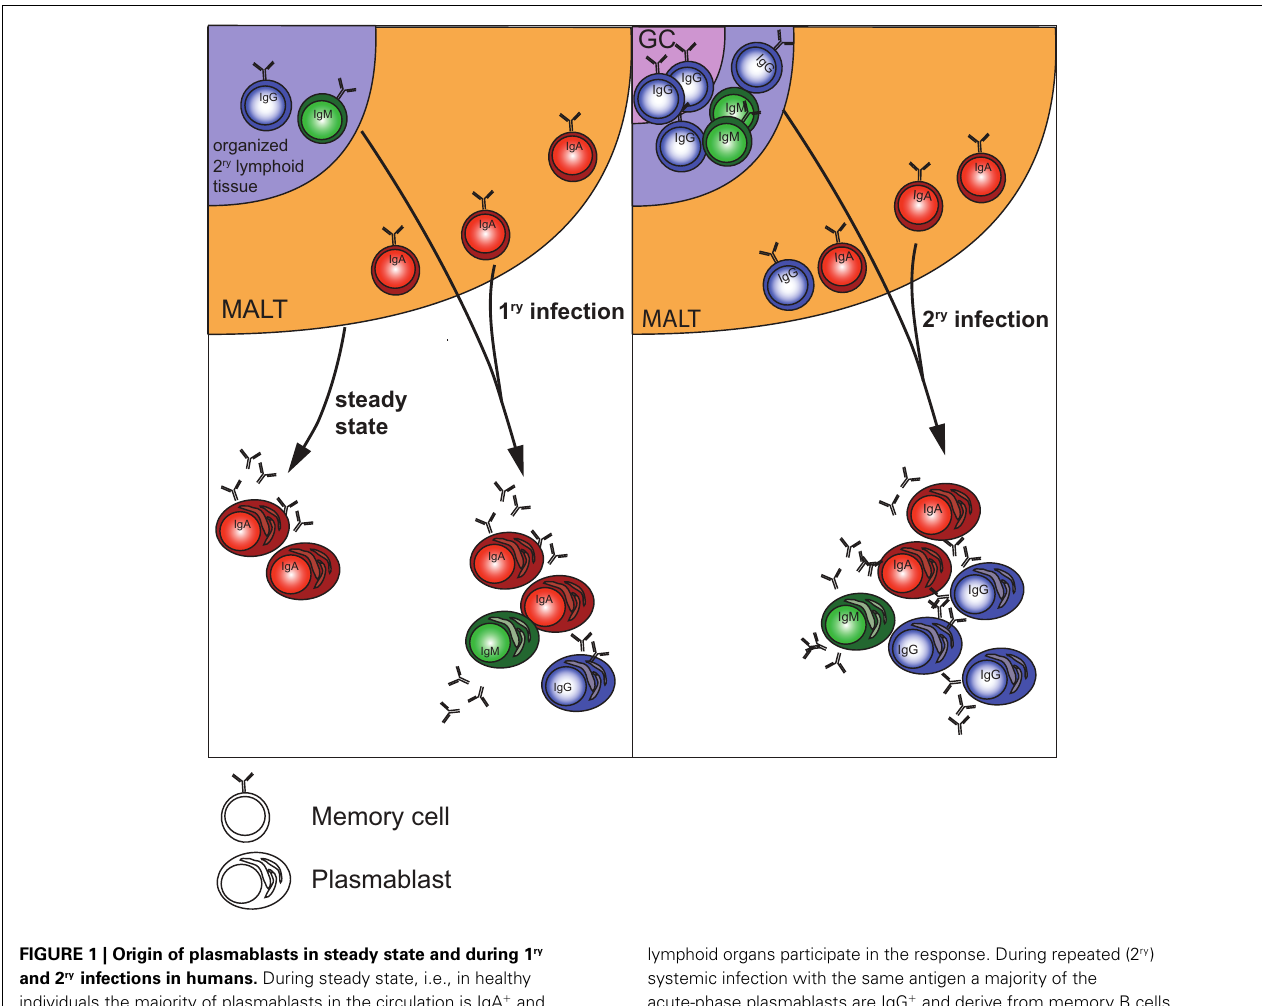
lymphoid organs participate in the response. During repeated (2 ry ) systemic infection with the same antigen a majority of the acute-phase plasmablasts are IgG + and derive from memory B cells, which have undergone class-switch and affinity maturation in germinal